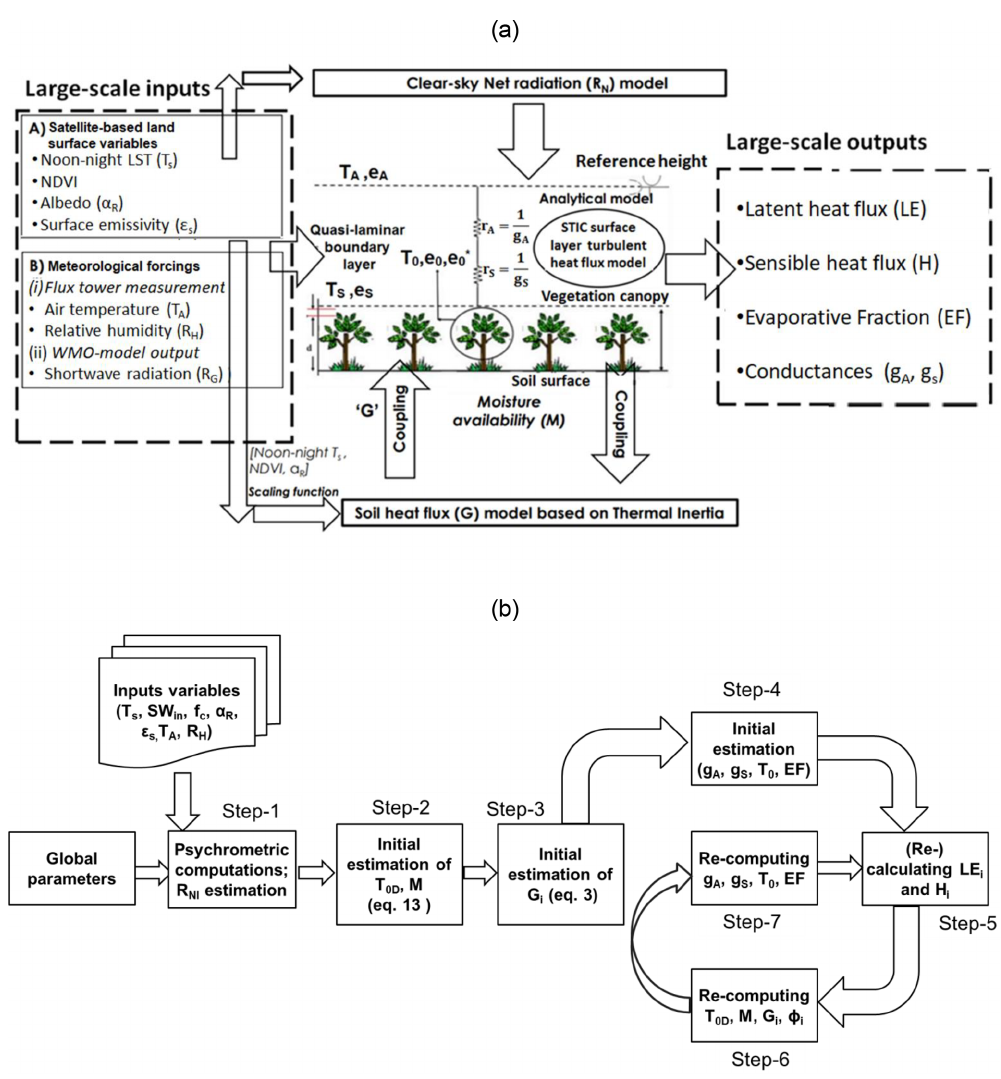
Figure 3. (a) Conceptual diagram of the STIC-TI model showing different input variables and model outputs and (b) algorithmic flow for estimating G and associated SEB fluxes through